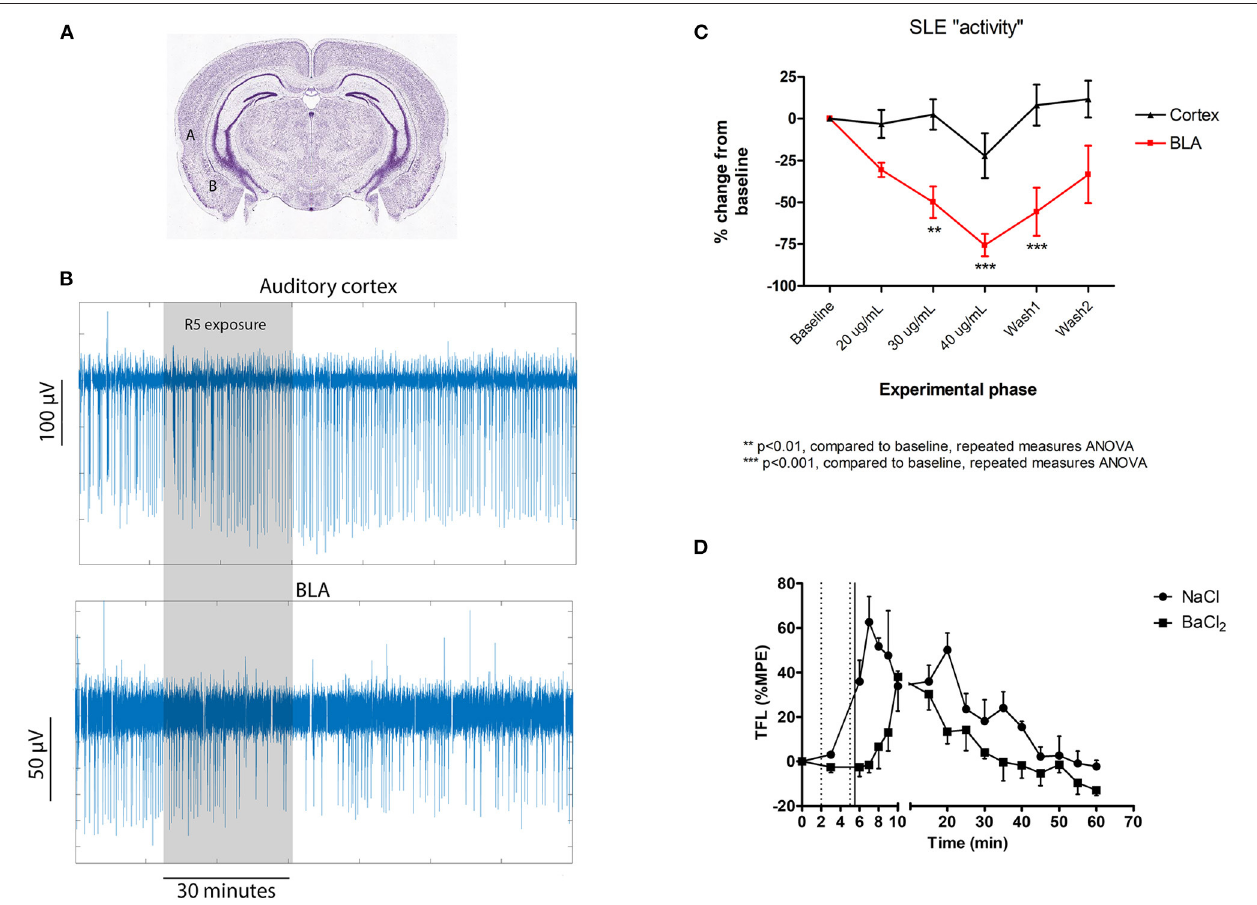
FIGURE 2 | Central subcortical effects of R5 in mouse cortical slices (A–C) and following intraventricular microinjection in rats (D) . (A) Cortical slice recording locations for comparing the effect of R5 on auditory cortex (labeled A) and basolateral amygdala (BLA- labeled “B”); (B) representative cortical slice recording traces and (C) slice group data comparing auditory cortex and BLA; (D) tail flick latency (TFL) as %MPE recordings according to intraventricular injection group. Dotted vertical lines represent saline/ BaCl 2 injection. Solid vertical line represents R5 injection. 2-way RMANOVA p = 0.005; max difference at 6, 7, 8, 9min p < 0.001